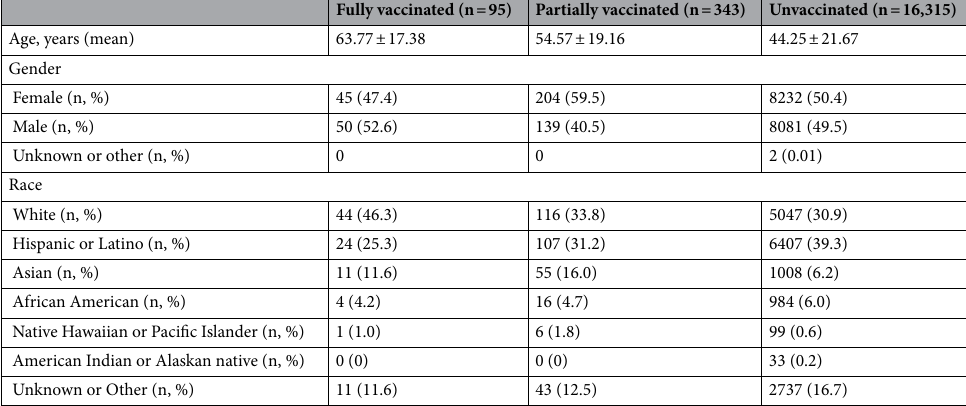
Table 2. Demographic information of patients with a positive SARS-CoV-2 result during the Alpha variant wave (n = 16,753 SARS-CoV-2 infections).